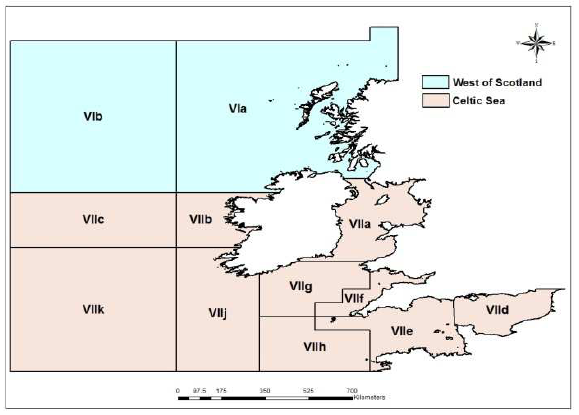
Figure 1. This map represents the ICES Divisions around Ireland that have been included in this study. Annual Mean of SST and Chl-a concentration has been extracted for each of the main areas, West of Scotland and Celtic Sea, as well as for each the ICES Division (VIa, VIb, VIIa, VIIb, VIIc, VIIf, VIIg, VIIh, VIIj, VIIk).